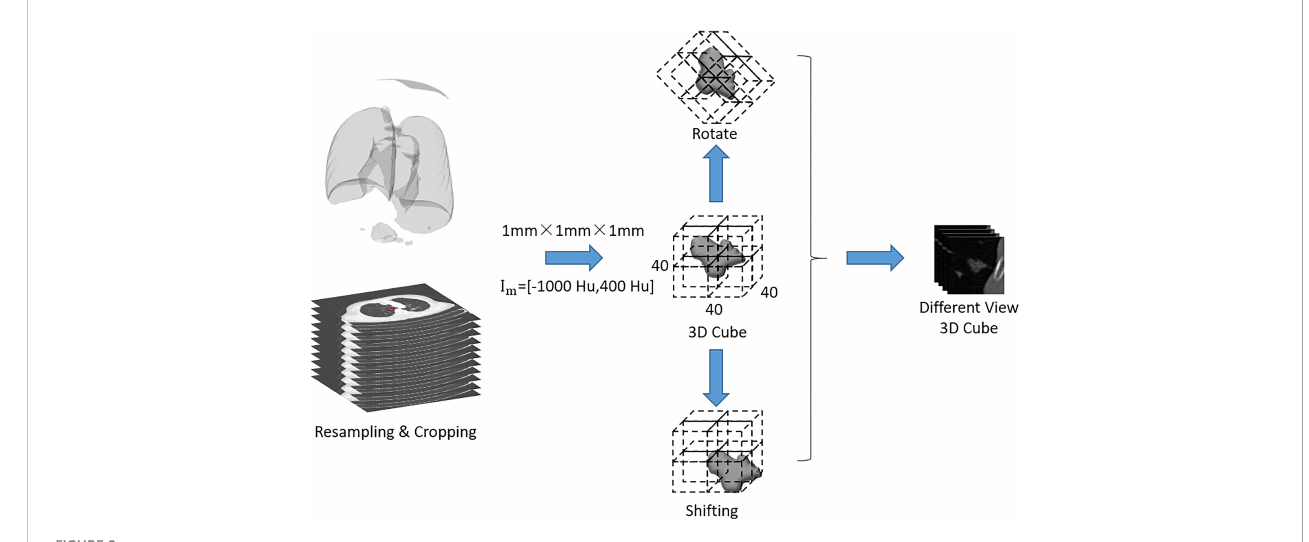
FIGURE 2 Flow chart of image